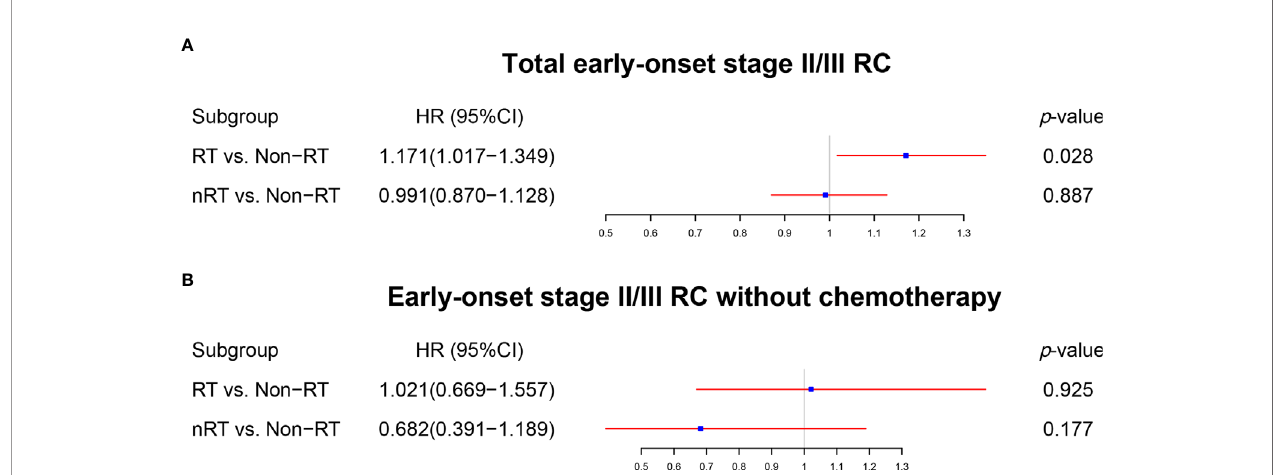
FIGURE 2 | The forest plot was used to show the results of the multivariable Cox regression in early onset stage II/III RC. (A) RT vs . non-RT and nRT vs . non-RT in total early onset stage II/III RC patients. (B) RT vs . non-RT and nRT vs . non-RT in early onset stage II/III RC patients without chemotherapy. (The results were extracted from Table S1